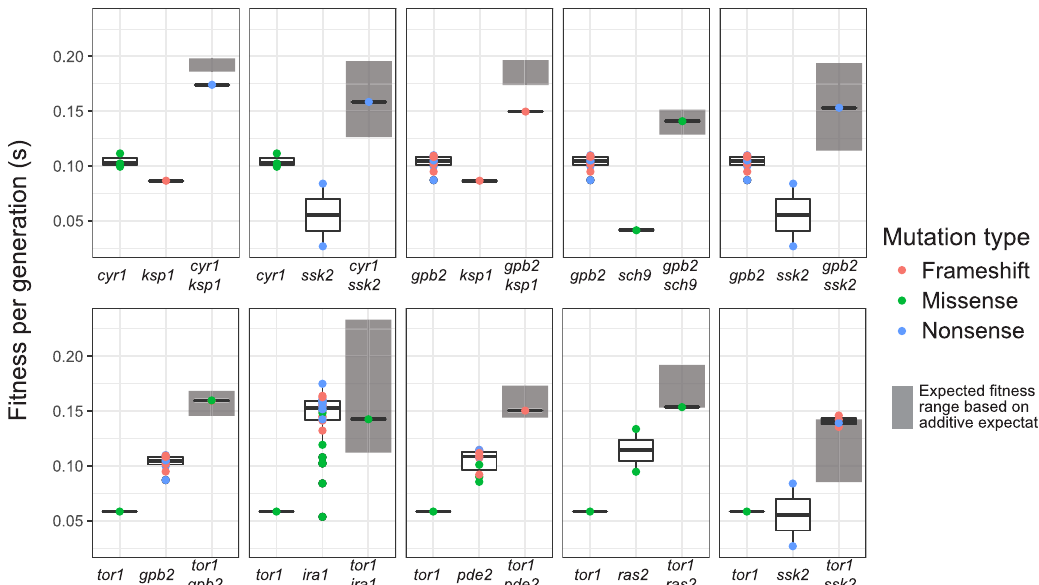
Fig. 5 Pairwise interactions among targets of selection have additive or negative effects when combined. The additive fi tness effects were estimated at gene-level for pairs of genes with adaptive alleles on the wild-type background (data from 1st-step evolution), and are annotated with gray bars, representing the 95% CI of the sum of the mean fi tness of mutants in each gene. The lower and upper hinges of each box correspond to the fi rst and third quartiles (the 25th and 75th percentiles). The bold line inside the rectangular de fi nes the median. The whiskers extend from the hinge to a value no further than 1.5 * IQR from the hinge (where IQR is the inter-quartile range). Additive fi tness effects are compared to the fi tness effects of genotypes with adaptive alleles at both genes (data from 2nd-step evolutions), as a proxy for epistasis. The dot color of the double mutants refers to the second mutation shown in each graph. The fi rst mutation matches the mutation type of the adapted ancestors ( cyr1 and tor1 are missense and gpb2 is a nonsense). Calculated fi tness values are provided in the Source data